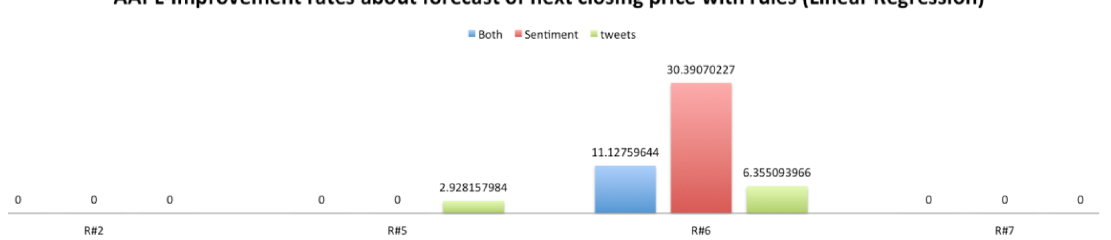
Figure 9. Improvement rates (expressed in %) of pattern intervals (rules) about AAPL by using linear